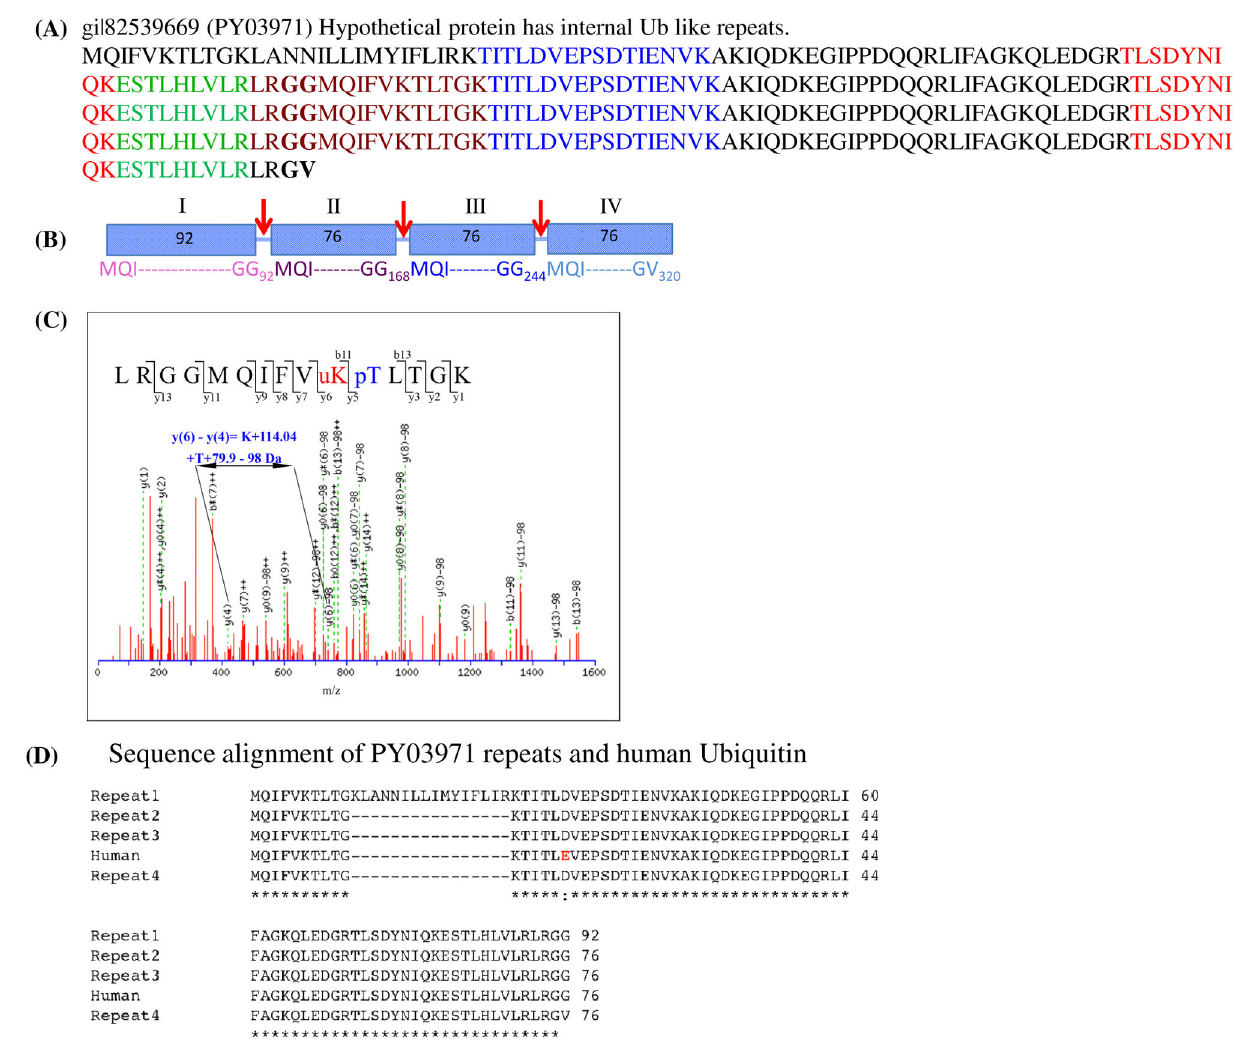
Figure 3. Ubiquitin moiety in P. yoelii . (A) P yoelii hypothetical protein (NCBI id: gi| 82539669; or Plasmodb id: PY03971 hypothetical protein) has four ubiquitin like internal repeats. Residues in blue, red, green and magenta belongs to peptides that were identified in MS analysis of tryptic digest of ~65-80 kDa band from FV gel. (B) Schematic representation of four ubiquitin repeats with cleavage sites shown in red arrows. Note that first subunit has an insert of 16 residues (aa11-26) raising its MW to ~92 kDa. Last repeat C-terminus has –GV instead of a –GG. (C) MS/MS spectrum of a peptide fromputative ubiquitin of P. yoelii putative ubiquitin. This peptide was present in the tryptic digest of the food vacuole SDS-PAGE 65-80 kDa band (see Figure 1). The peptide showed a linear peptide linkage between –G76 and M1 of two µb (Ub1 and Ub2) molecules while the K6 of Ub2 is the site for attachment of third Ub (Ub3) molecule. (D) CLUSTAL W alignment of four repeats from PY03971 protein and human ubiquitin. Repeats 2 and 3 have the same sequence as that of human (and mouse) except E16 in human (and mouse) is replaced with a D in Plasmodium spp . Observation of ‘D16’ in sequenced peptides [see (A)] indicates the Ub linked to protein in ~65-80 kDa band is of parasite origin and not that of host. doi: